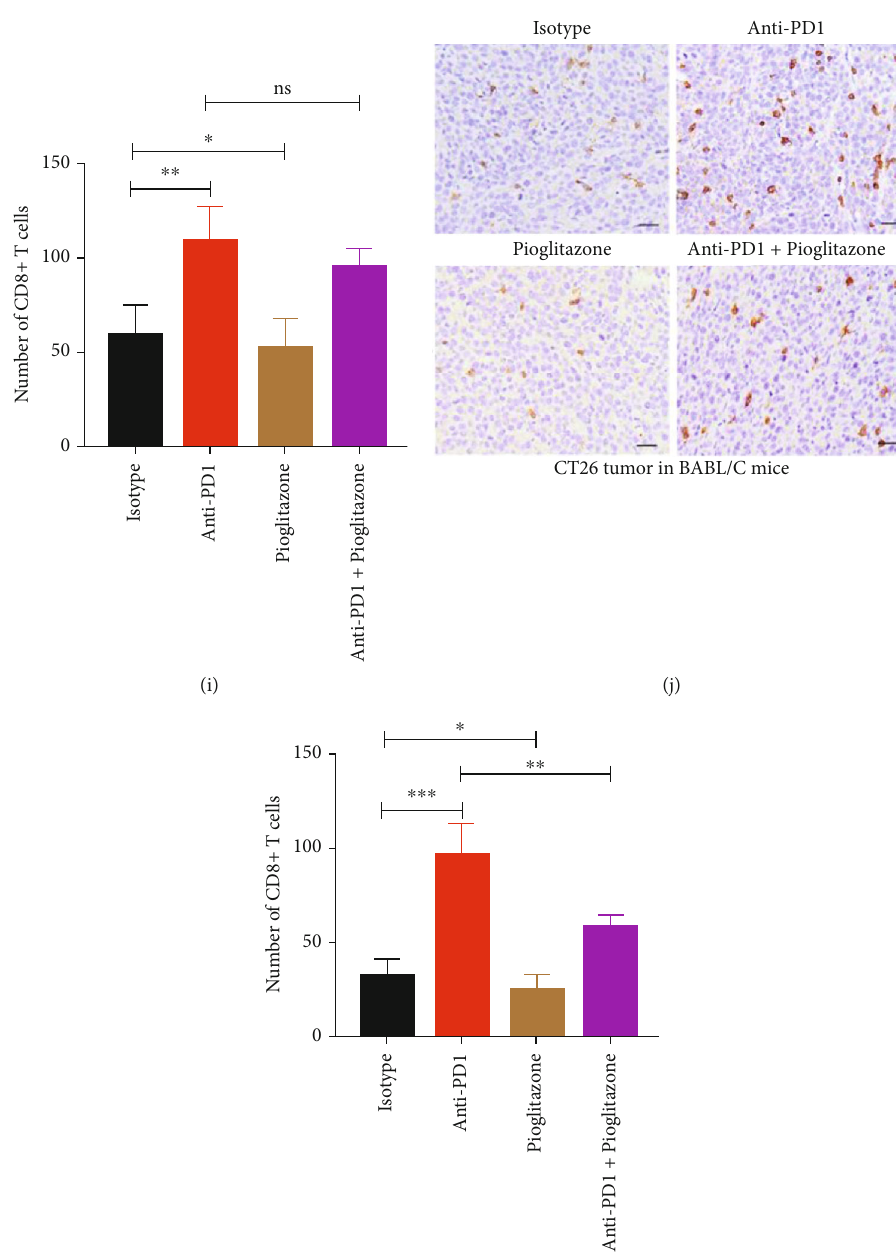
Figure 5: Pioglitazone inhibits colon tumor growth and weakens tumor immune responses to anti-PD1. (a) Schematic overview of experimental design combined for (b) – (k). (b – d) Tumor growth (b) and weight (c) from MC38 tumor-bearing C57BL/6 mice were shown ( n = 7 ). (e – g) Tumor growth (e) and weight (g) from CT26 tumor-bearing on BABL/C mice were shown ( n = 7 ). (h and i) Sections from MC38 subcutaneous tumors were stained with anti-CD8 antibody by immunohistochemistry (h), and CD8 + T cells in fi ltration were analyzed in (i). (j and k) Sections from CT26 subcutaneous tumors were stained with anti-CD8 antibody by immunohistochemistry (j), and CD8 + T cells in fi ltration were analyzed in (k). Scale bars: 100 μ m. Data were analyzed by two-way ANOVA (b and e) and t -test (c, f, i, and k). ns: no signi fi cance; ∗ p < 0 : 05 , ∗∗ p < 0 : 01 , and ∗∗∗ p < 0 : 001 . Error bars denote for the